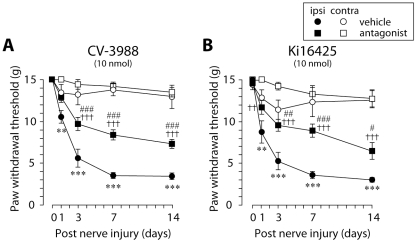
PAFR and LPAR antagonists suppress the development of tactile allodynia by injury to the L5 spinal nerve.A, B. Administration of PAFR antagonist CV-3988 (10 nmol/10 µl) (A) and the LPAR antagonist Ki16425 (10 nmol/10 µl) (B) through a catheter whose tip was positioned near the L5 DRG once daily for 14 days after nerve injury suppressed the development of tactile allodynia. **p<0.01, ***p<0.001 compared with the threshold of the vehicle-treated group on day 0. ††p<0.01, †††p<0.001 compared with the threshold of the antagonist-treated group on day 0. #p<0.05, ##p<0.01, ###p<0.001 compared with the threshold of the vehicle-treated group at each time point. All data are presented as mean ± SEM of the paw withdrawal threshold of five to eight animals.